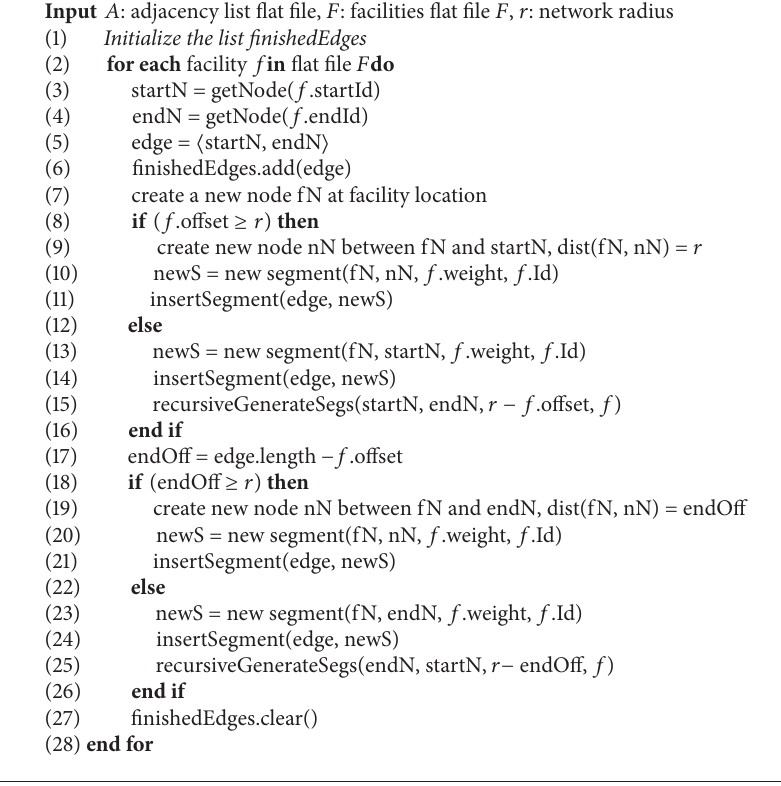
Algorithm 1: generateSegments( 𝐴 , 𝐹 , 𝑟